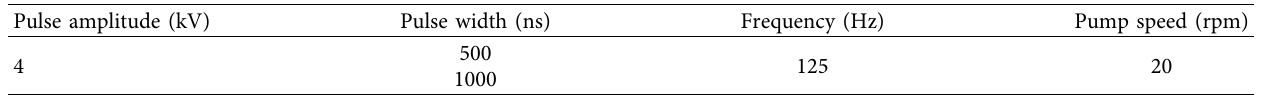
Table 4: The properties of the pulse used in practical